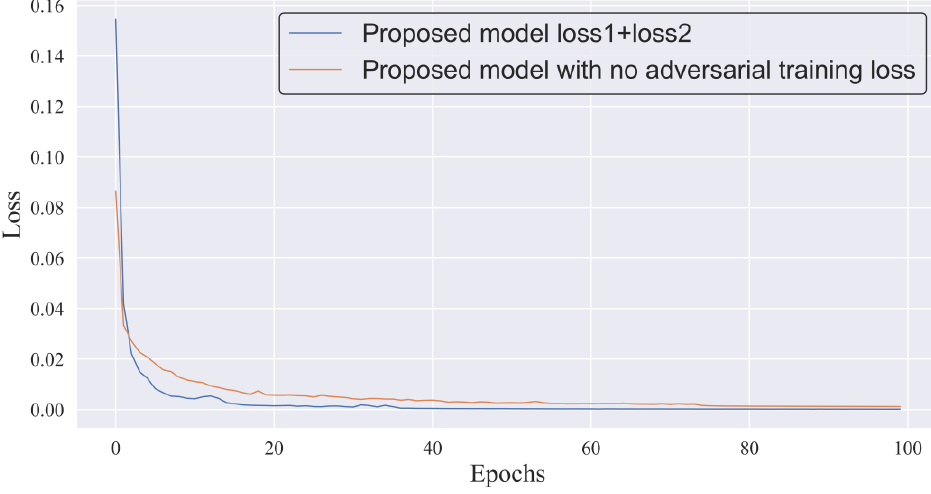
Figure 12. Loss with adversarial training and without adversarial training.